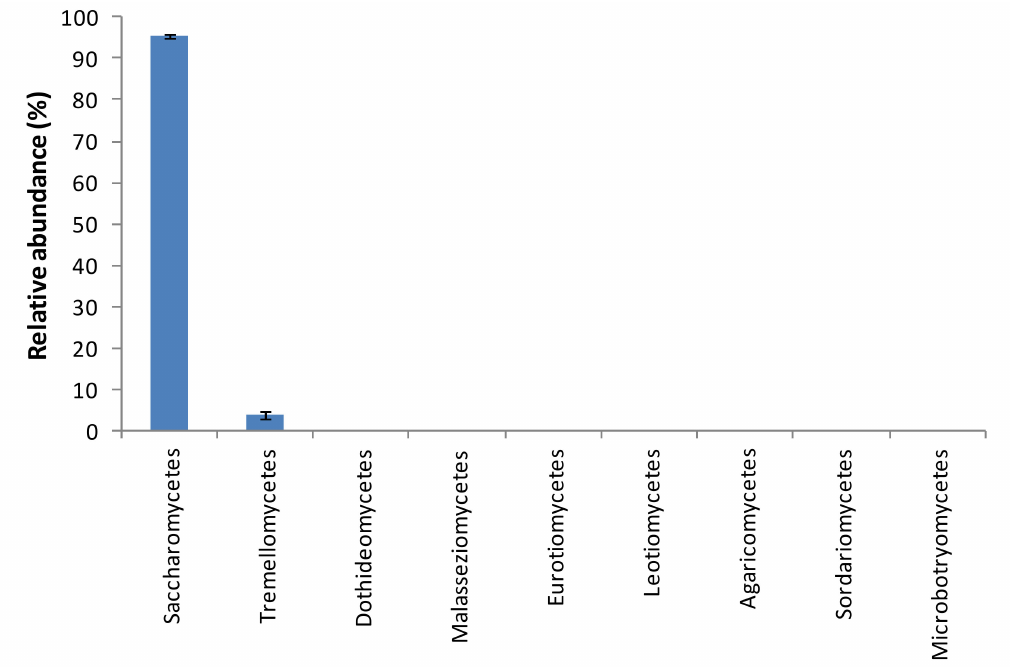
Figure 6. Fungal diversity at class level in the orange juice processing waste examined by Illumina assay